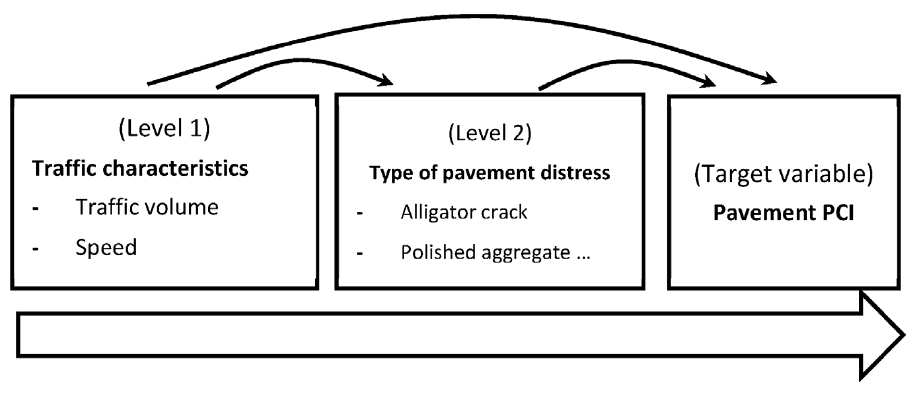
Figure 5. The hierarchy of PCI and explanatory variables.